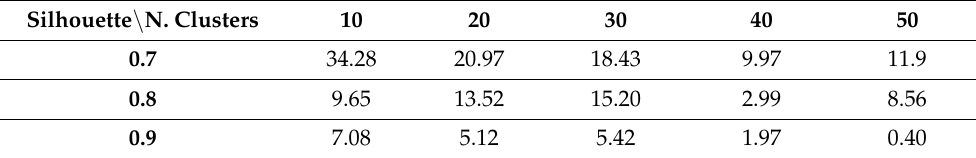
Table 46. Clustering performance in terms of silhouettes using normalized data. Silhouette \ N. Clusters